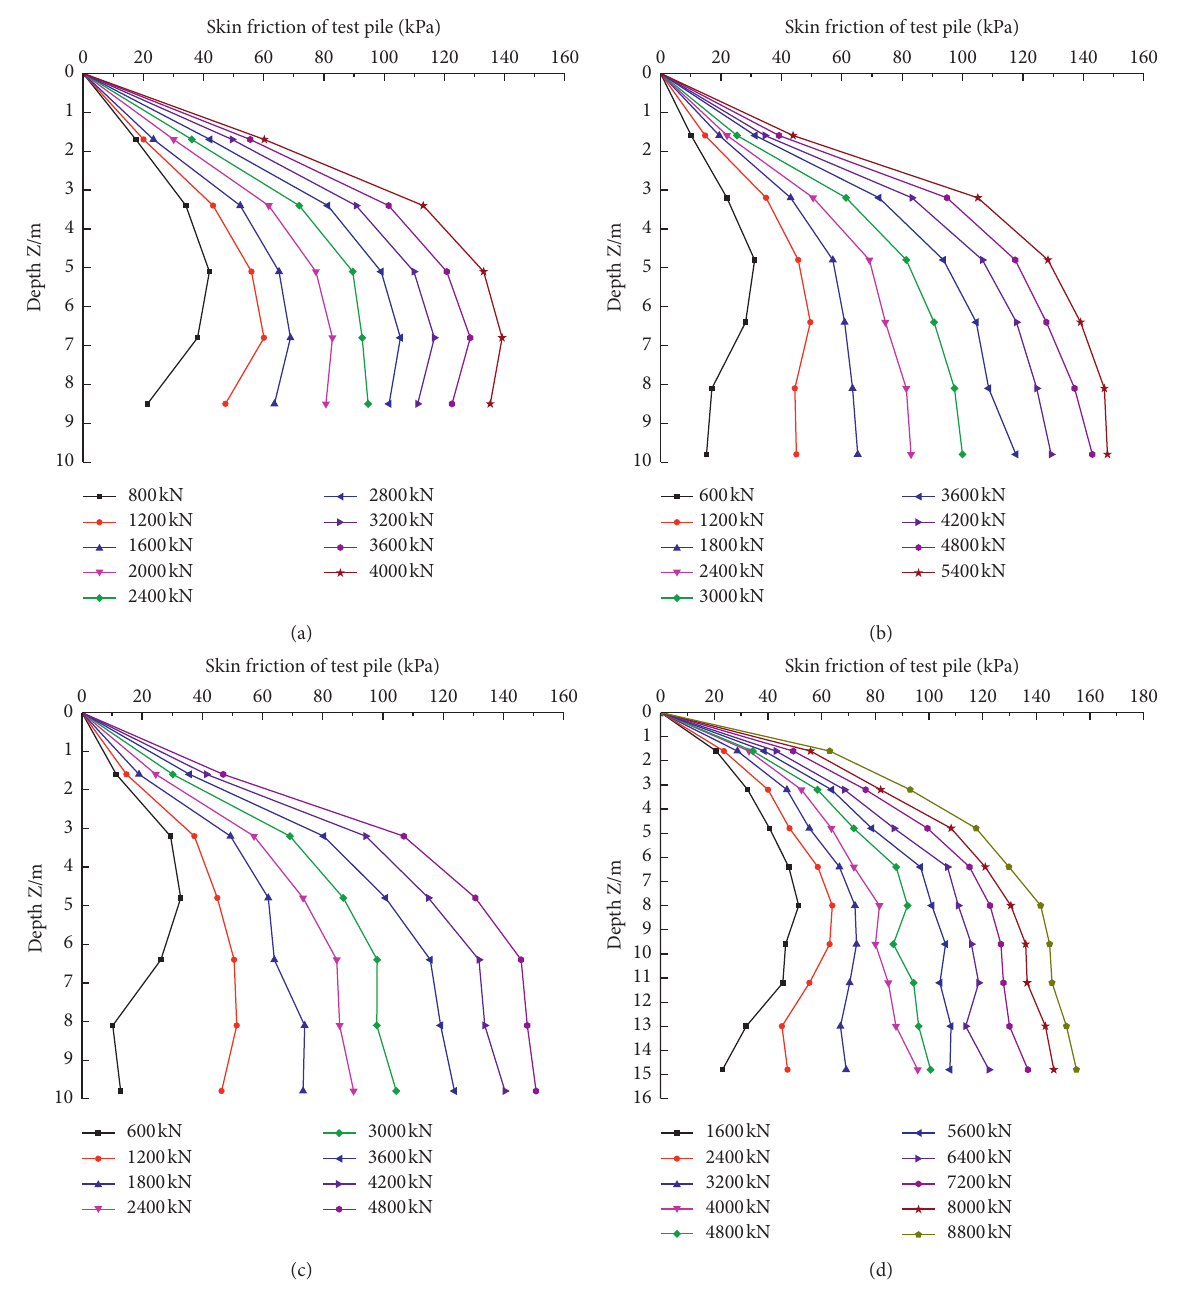
Figure 11: Distribution of shaft skin resistance on each pile. (a) No. 1 pile. (b) No. 2 pile. (c) No. 3 pile. (d) No. 4 pile. Table 6: Value of shaft skin resistance of piles at different depths when reaching ultimate bearing